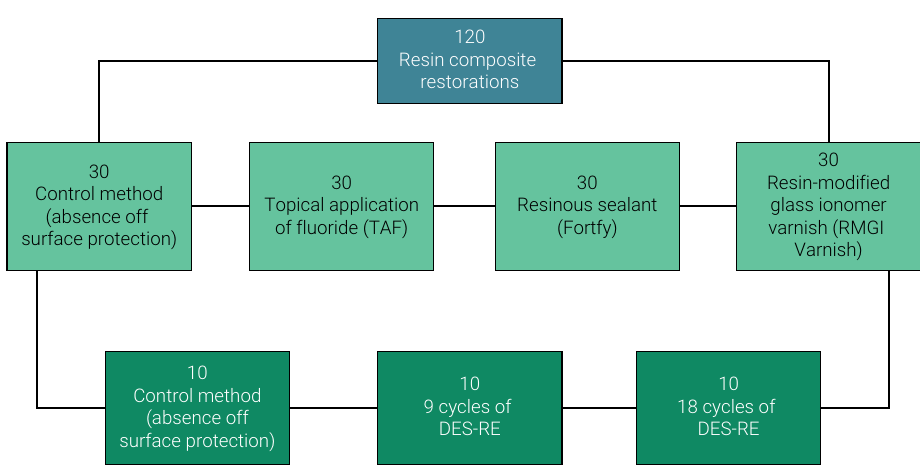
Figure 1. Distribution of the control method and levels of erosive